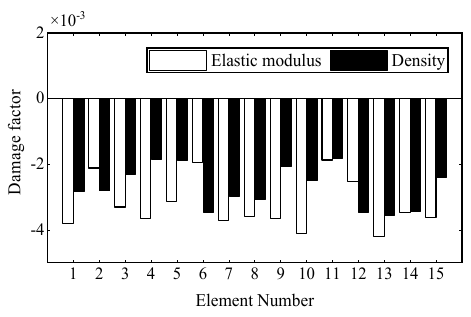
Figure 11. Identified results in the intact model.